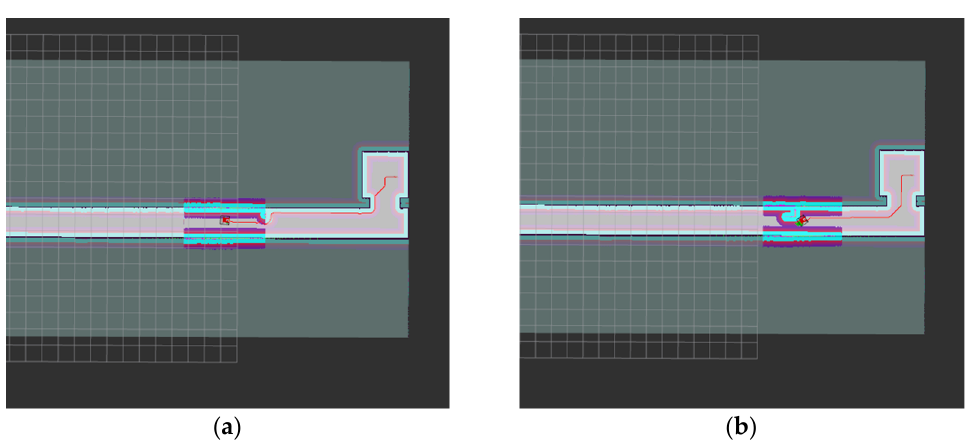
Figure 14. Global path plan.